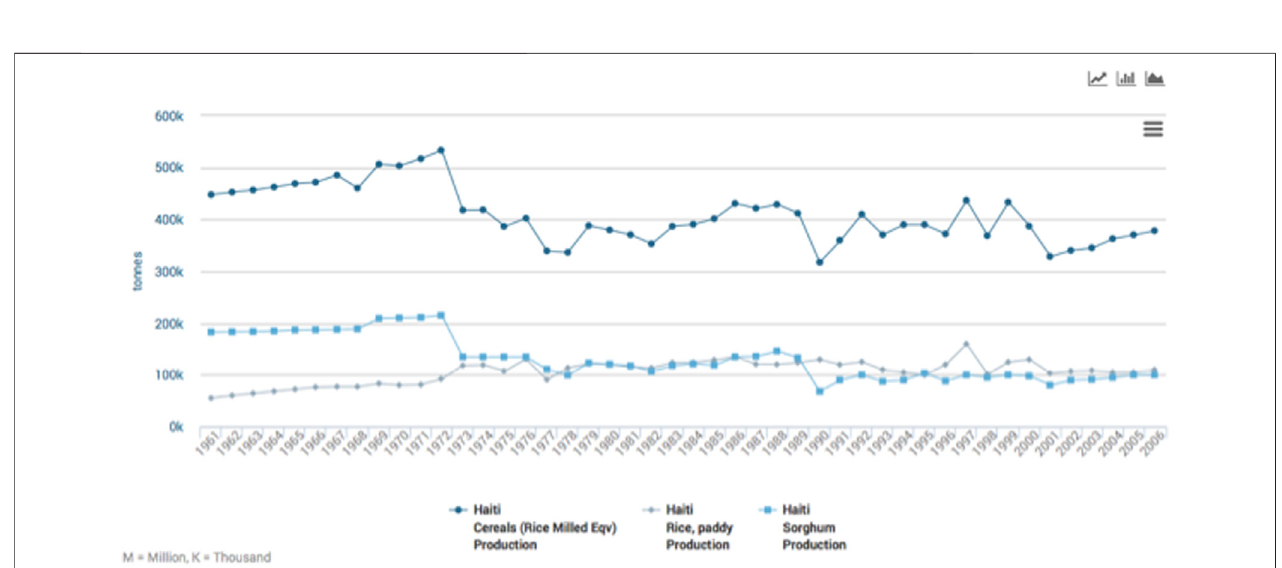
FIGURE 2 | Declining and stagnation of national production — sorghum, rice, cereals.